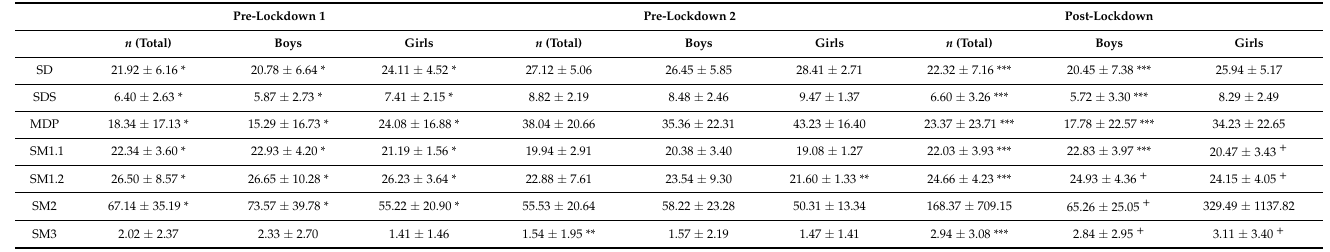
Table 1. The manual dexterity test results between pre-lockdown 1, pre-lockdown 2 and post- lockdown using descriptive